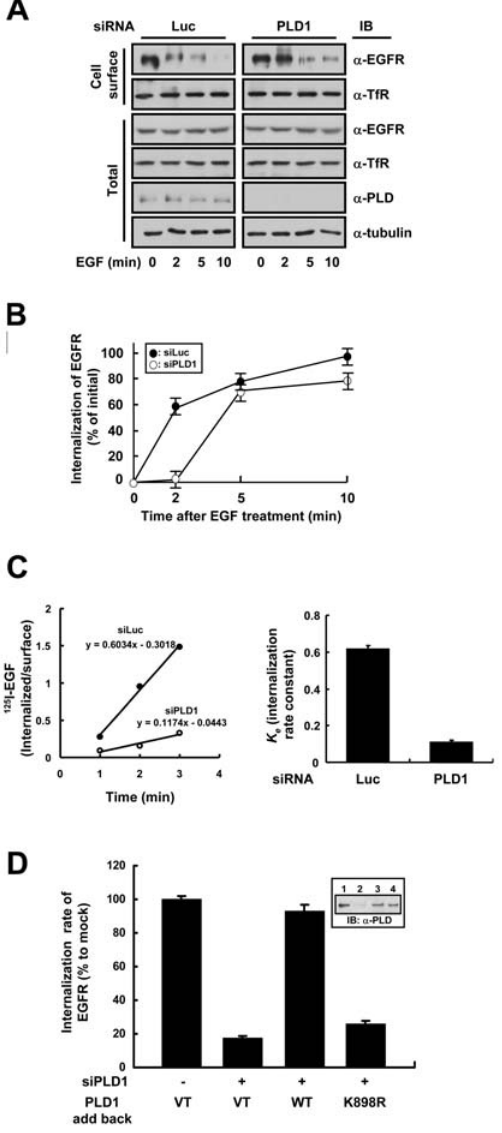
Figure 1. Wild type but not lipase inactive PLD1 facilitates EGFR endocytosis. (A) HeLa cells were transfected with control (Luc) or PLD1 (PLD1) siRNA to deplete endogenously expressed PLD1. After serum starvation for 12 h, EGF was treated at 20 nM for 0, 2, 5, or 10 min and biotinylation of cell surface proteins was performed. Biotinylated (Cell surface) proteins were separated using streptavidin beads and analyzed by western blotting. A representative immunoblot of three independent experiments is shown. (B) Quantitation of EGFR internalization in HeLa cells. The kinetics of the EGF-induced internalization of EGFR in HeLa cells transfected with either luciferase (closed circle) or PLD1 (open circle) siRNA. (C) HeLa cells depleted of endogenous PLD1 were incubated with 125 I-EGF at 37 u C. k e valueswere measured during linear 3-min time course and expressed as per cent of the mean values obtained for control-transfected cells. The data represent mean values from three independent experiments and the error bars represent standard deviations. (D) After depleting endoge- nous PLD1 using PLD1 siRNA, endogenous level of wild type or K898R PLD1 was expressed in HeLa cells. The internalization rate of EGFR was calculated as described in (C) and is shown as a bar graph reflecting the average of three independent experiments and standard deviations. Immunoblots in the inset indicate the expression levels of the constructs